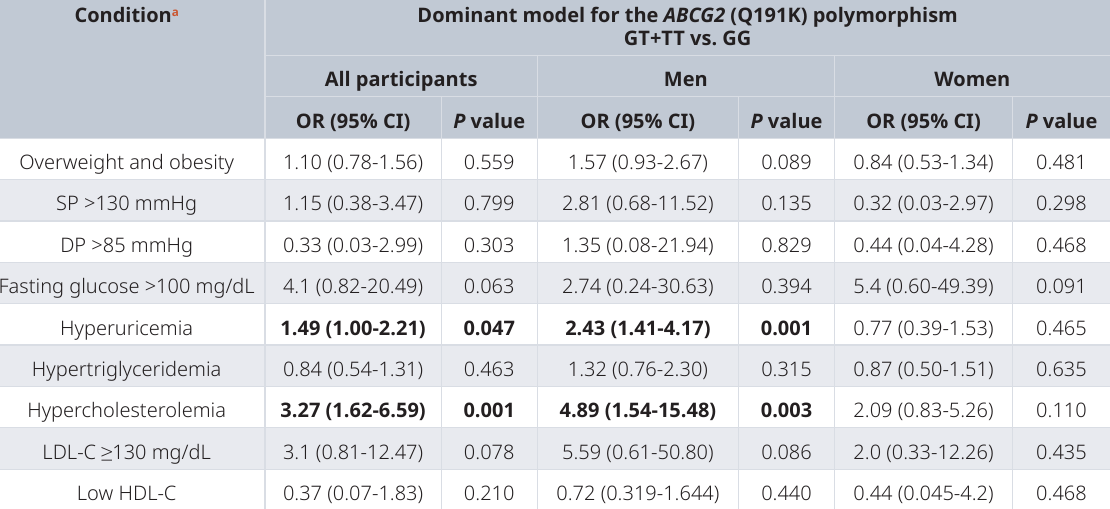
Table 4. Analyses for the ABCG2 (Q191K), SLC22A12 (517G>A), and XDH (518T>C) polymorphisms and risk associated by sex. Condition